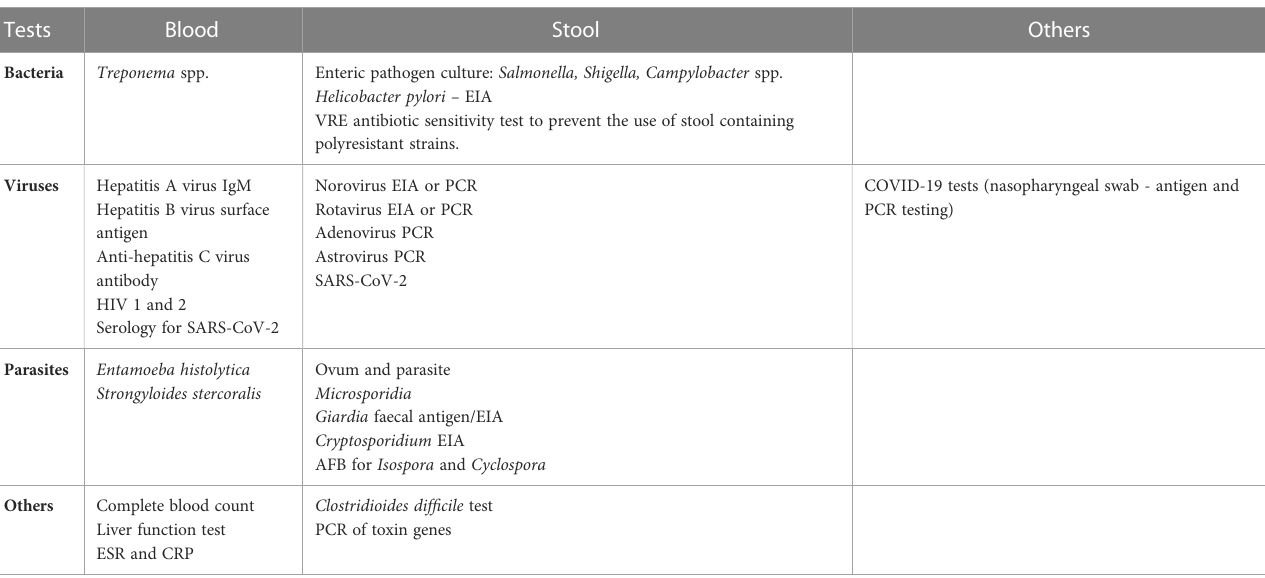
TABLE 2 Suggested laboratory tests for potential donors for faecal microbiota